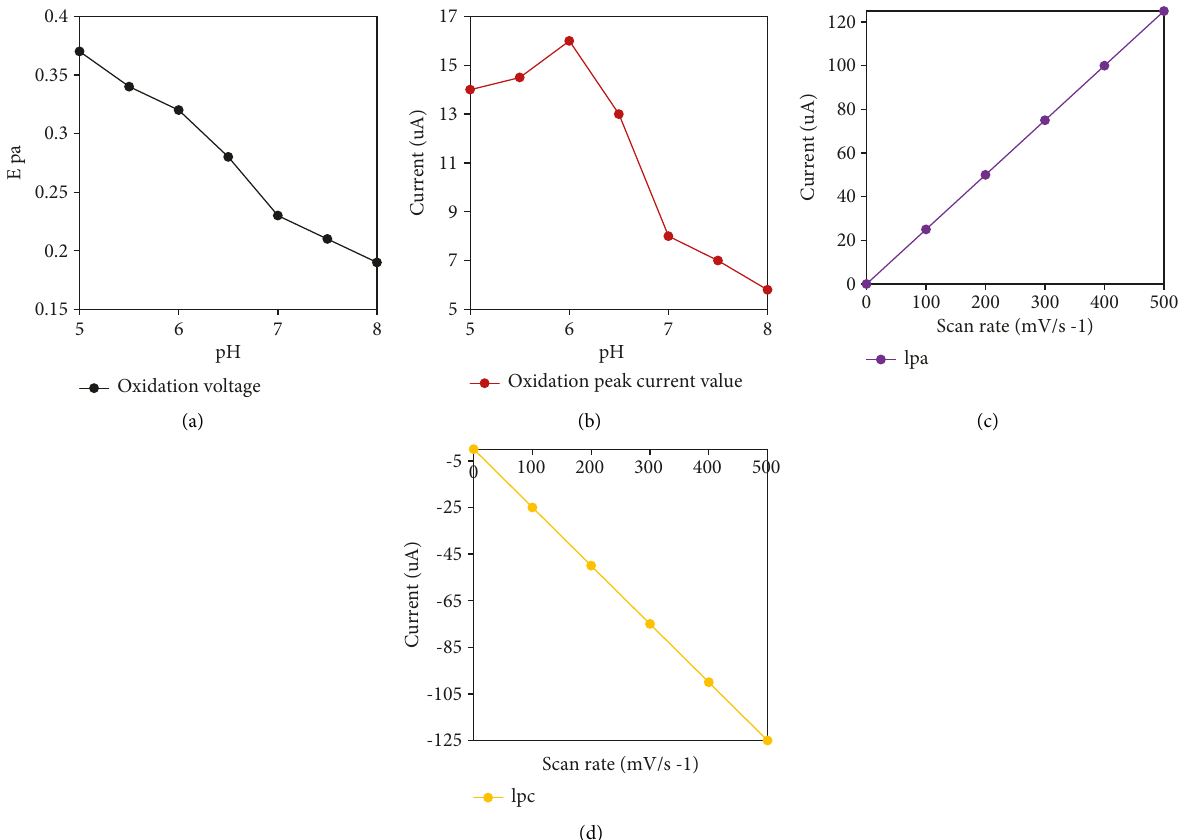
Figure 6: The linear relationship between oxidation voltage, current, and pH value and the linear relationship between redox peak current and scan rate.